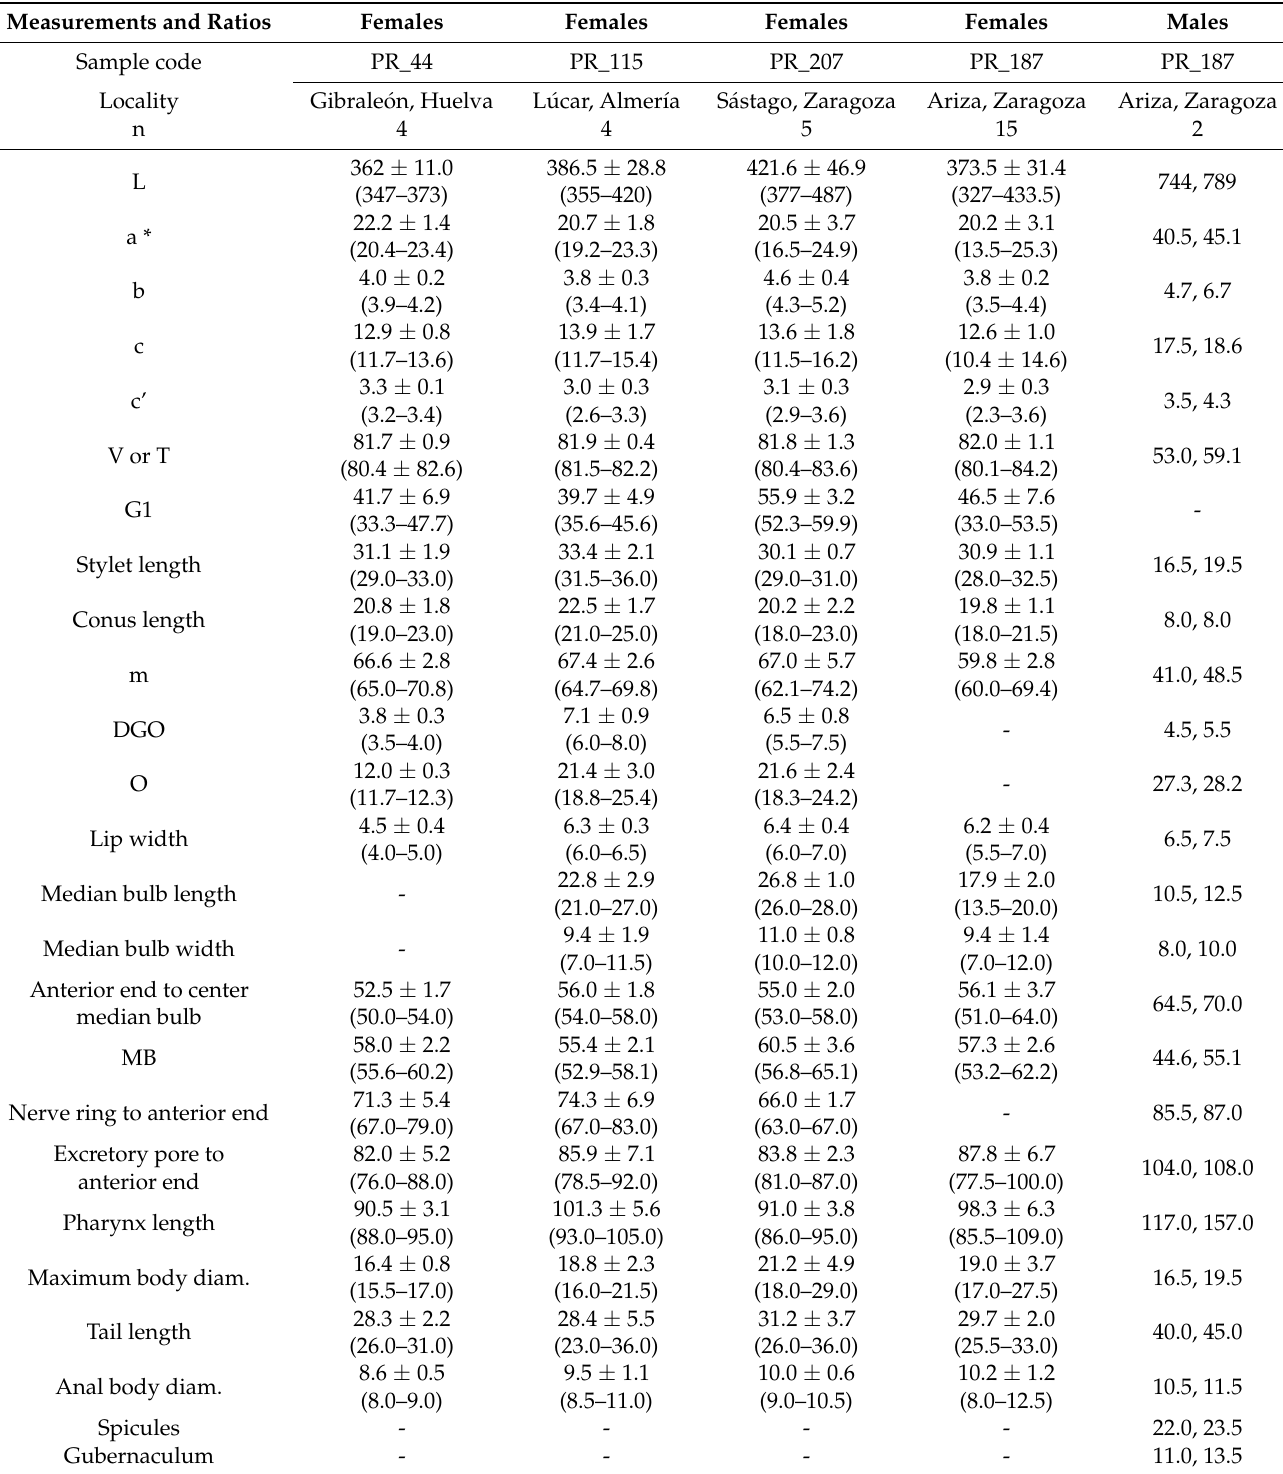
Table 7. Morphometrics of Paratylenchus hamatus Thorne & Allen, 1950 from several localities in Spain. All measurements are in µ m and in the form: mean ± s.d.